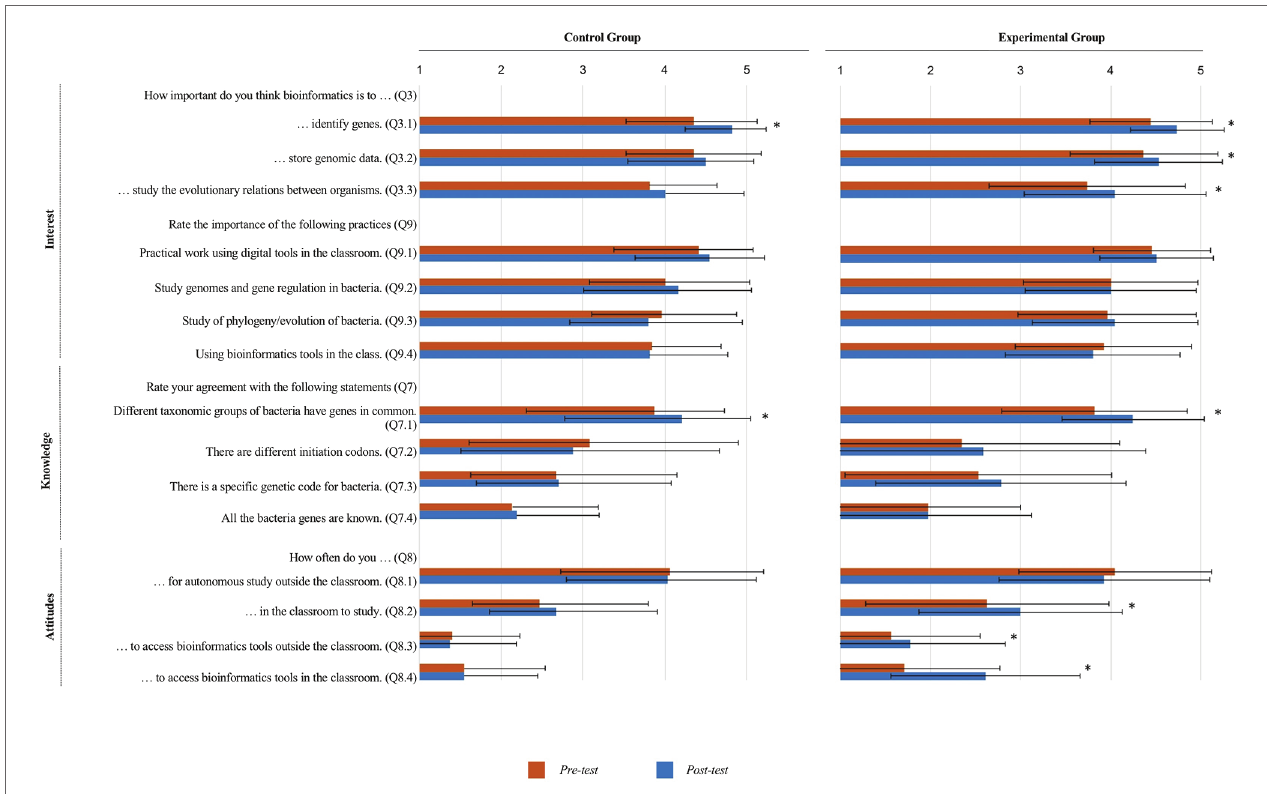
FIGURE 6 | Students’ knowledge, interest, and attitudes toward the integration of bioinformatics in science